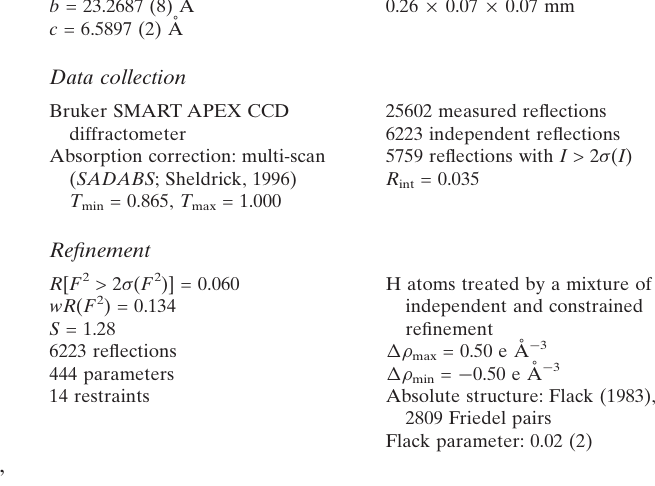
parameter ratio = 14.0.